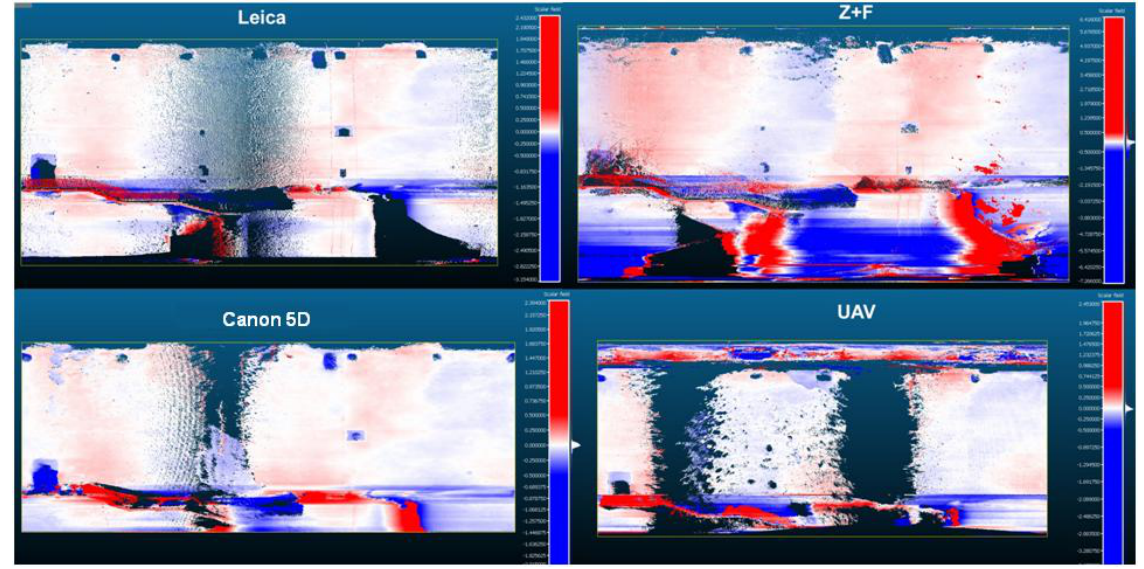
Figure 8. Map of the deviations between the points and the theoretical